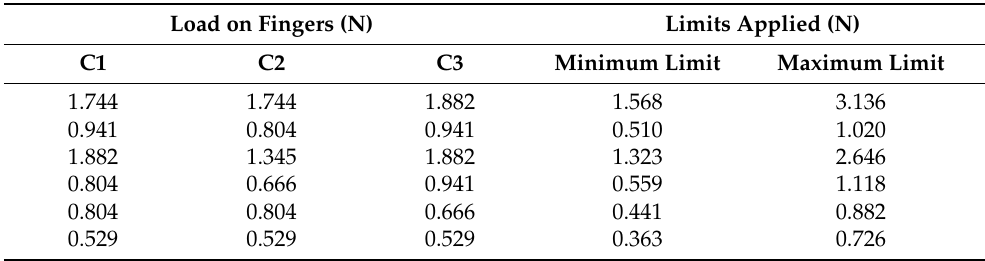
Table 1. Force exerted by the gripper by variation in the potentiometer. Source: (Own). Load on Fingers